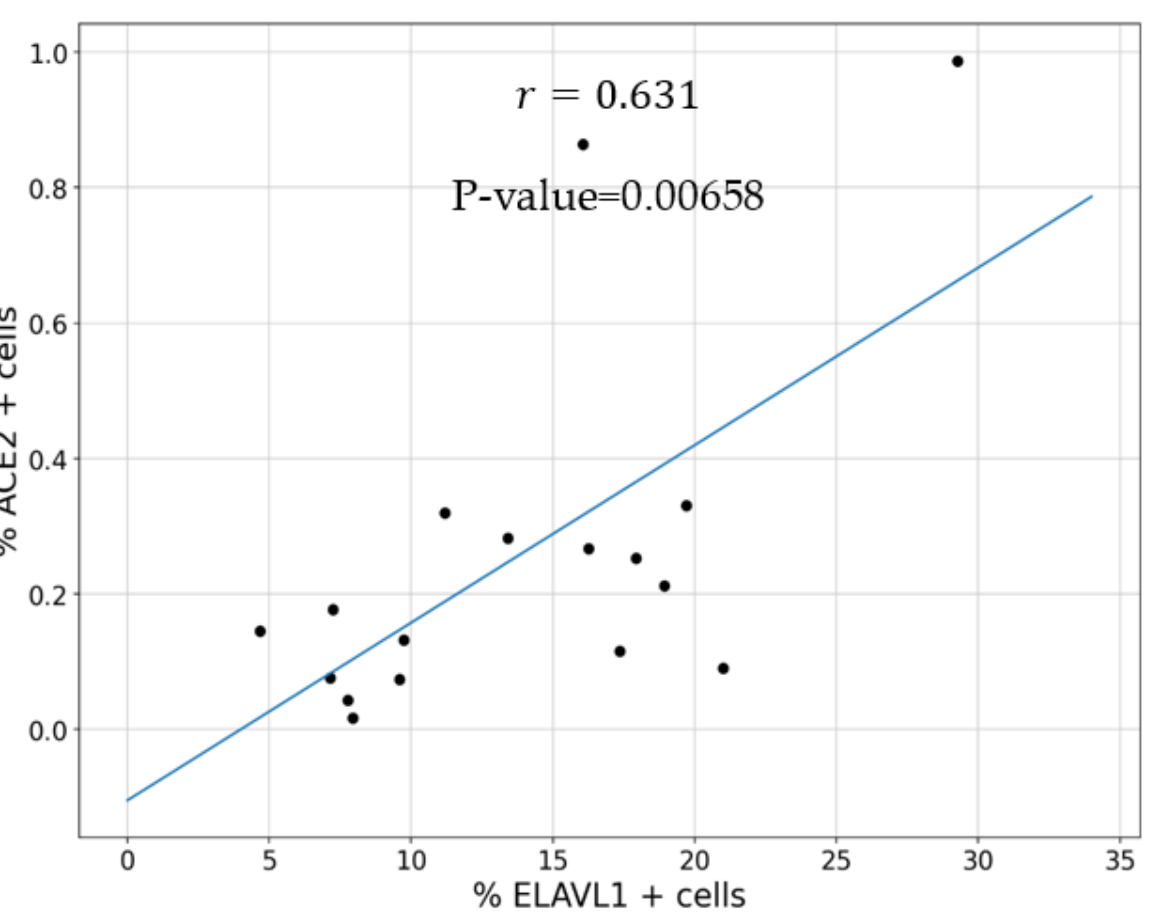
9 of 24 Figure 2. ELAVL1 single-cell level expression in COPD . ( A ) Different cell populations in the COPD single-cell RNA-seq data [29]. ( B ) Dotplot shows the expression of ELAVL1 in different cell popula- tions. The size of the circle denotes the % of cells expressing ELAVL1 . The darkness of the circle shows the expression level. Aberrant_basaloid, mesothelial, VE_peribronchial, PNEC, ciliated, and club cells are among the cell types with the highest expression of ELAVL1 . ( C ) Percentage of ELAVL1 + cells: on the right side (positive % difference) is the cell types with higher % of ELAVL1 + cells in control. On the left side are the cell types with higher % of ELAVL1 + cells in COPD (0.1 denotes 10%). Finally, we explored whether there was a correlation between ELAVL1 and ACE2 ex- pressions in COPD cells that express both genes. We found a significant positive correla-